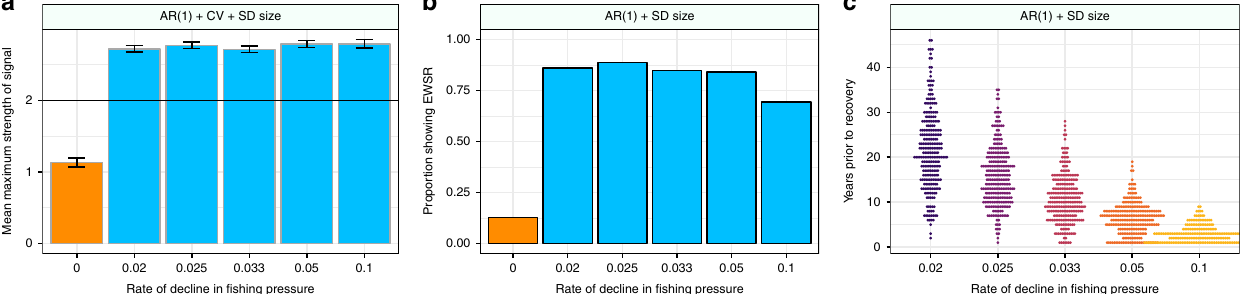
Fig. 4 Ef fi cacy of single warning signals in predicting the recovery of cod populations. a Metric with the greatest difference between the signal strength in the non-collapse and collapse time series, the greatest mean strength across all rates of decline, and the highest mean signal strength in any single rate of change (AR(1) + CV + SD size) of EWSR between the start of the decline in fi shing pressure (2040) and the recovery time of each time series. Error bars show 1 SE. b Metric with the greatest difference between the proportion of time series showing false positive signals at a 2 sigma threshold (orange bars) and proportion of time series showing true positive signals (blue bars) – AR(1) + SD size. c Distribution in time of EWSR at a 2 sigma threshold for